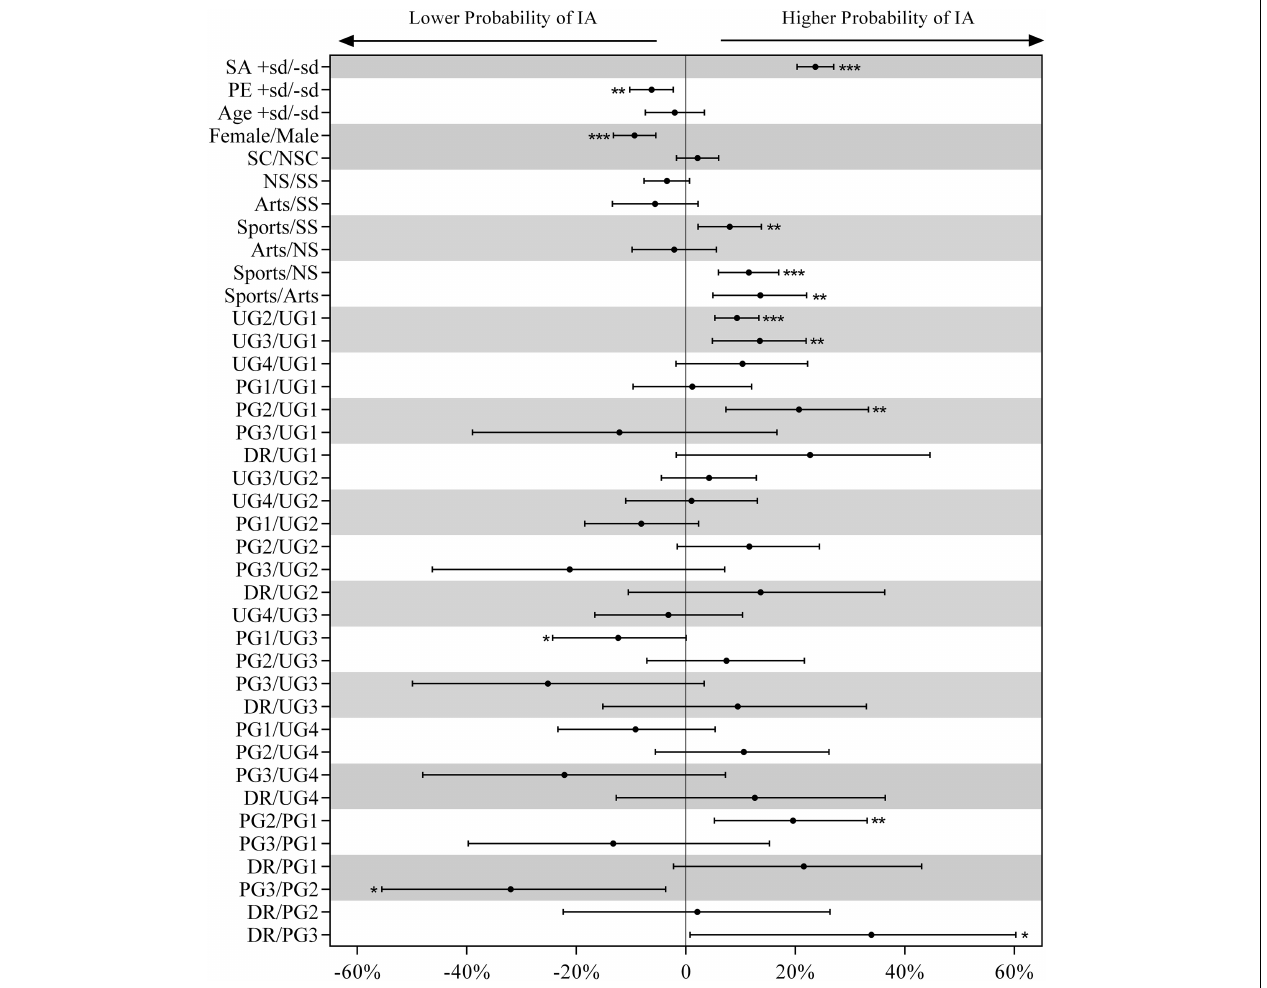
FIGURE 1 | Effects of IA, PE, age, gender, single child, major, and grade on the SA estimated from the Poisson regression. Dots are the effects in percent units, and error bars are their 95% compatibility intervals. Asterisks indicate the significance level as follows: * p < 0.05, ** p < 0.01, *** p < 0.001. PE, physical exercise; SA, social anxiety; IA, internet addiction; NIA, no internet addiction; SC, single child; NSC, non-single child; SS, social science; NS, natural science; UG1-UG4, 1st–4th year of undergraduate; PG1-PG3, 1st–3rd year of postgraduate; DR,